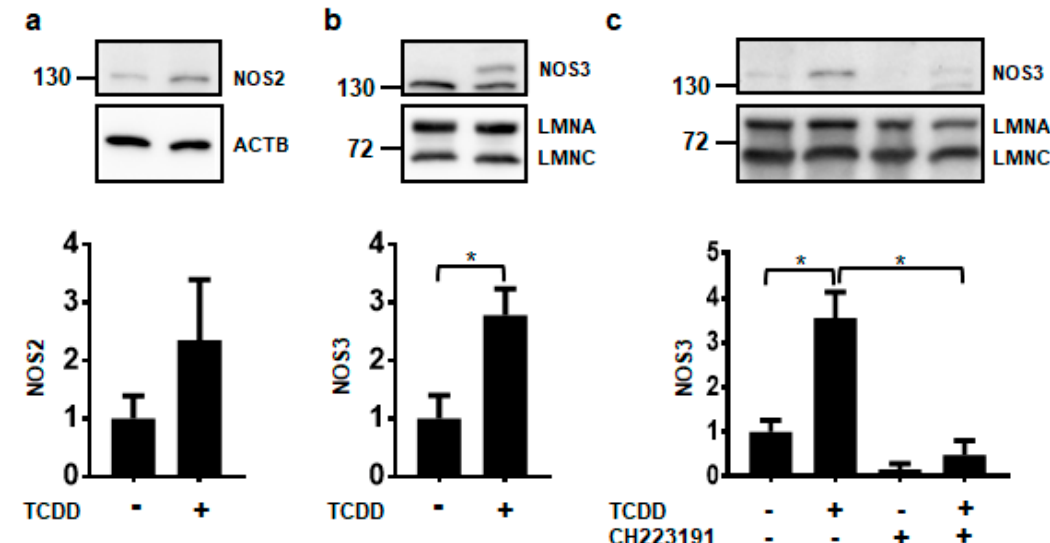
Figure 2. Activation of the AHR increases the expression of NOS3 protein. Protein levels were measured from NHEKs treated with DMSO (0.2%, vehicle) or TCDD (10 nM) for 72 h ( a – c ). In ( c ) NHEKs were also treated with the AHR antagonist, CH223191 (1 µ M). Levels of NOS2 ( a ) and NOS3 ( b , c ) (mean ( n = 3) +/ - SD) were quantified by densitometry, normalized with levels of either Actin Beta (ACTB) or Lamin A (LMNA), as indicated, and plotted relative to DMSO, set to a value of one (lower panels). The numbers to the left correspond to molecular weight markers in kilodaltons. * indicates a significant di ff erence, p < 0.05. Data were analyzed using two-tailed Student’s t -test ( a , b ) or two-way ANOVA followed by Tukey’s post hoc tests ( c ). These results were replicated in NHEKs from a different source.